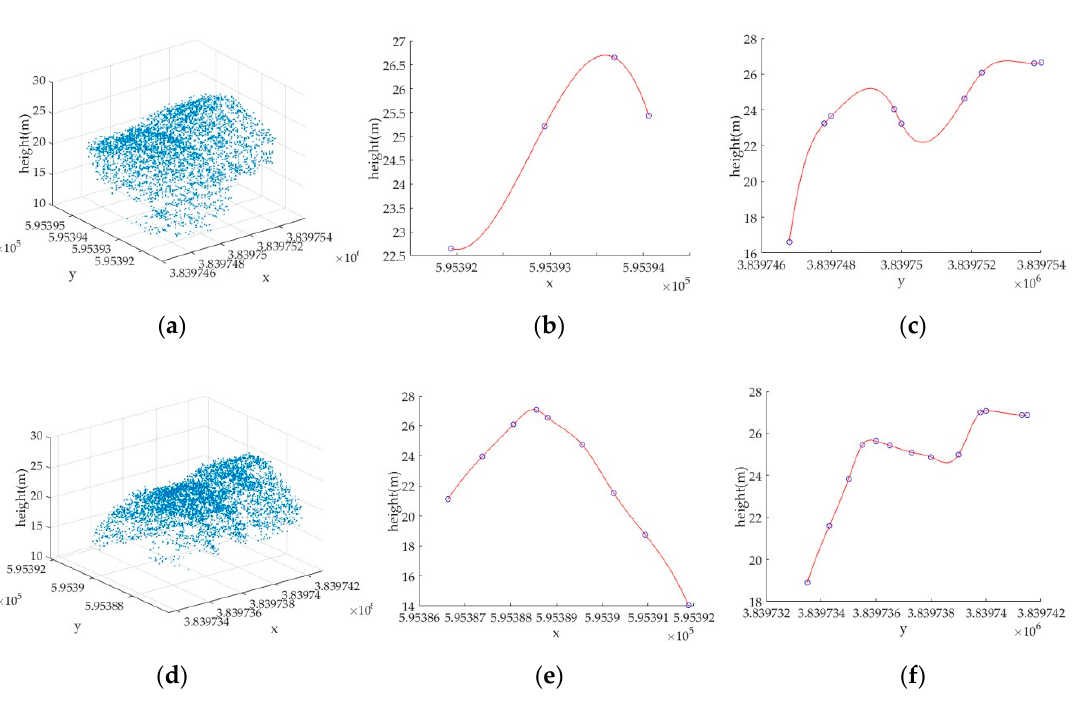
Figure 5. Two-cluster examples and their corresponding shape curves both in the x- and y-direction: ( a , d ) two-cluster samples, ( b , e ) their shape curves in the x-direction, and ( c , f ) their shape curves in the y-direction.